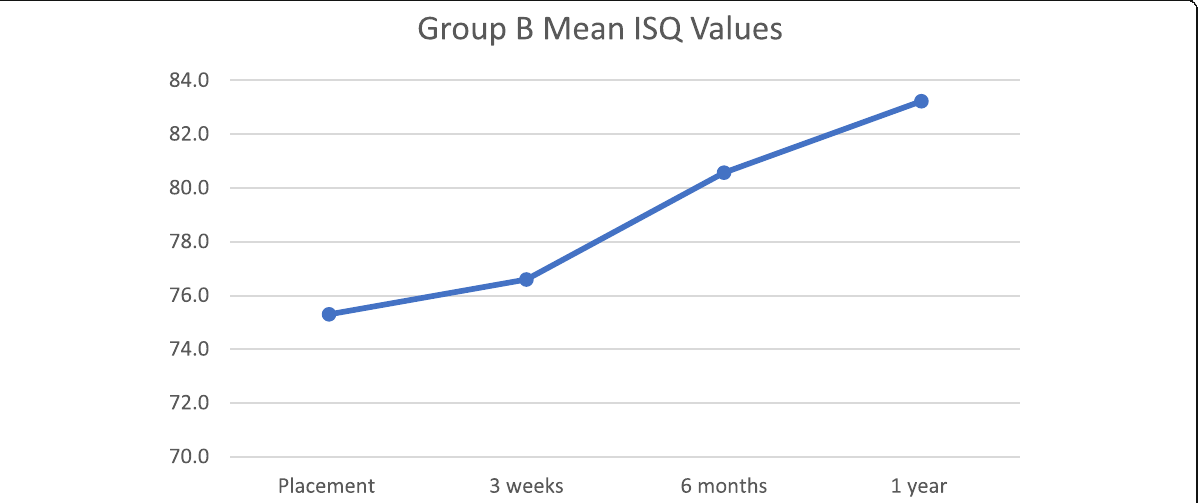
Fig. 2 Group B mean ISQ values. This graph depicts change in mean ISQ values for Group B at placement, 3 weeks, 6 months, and 1